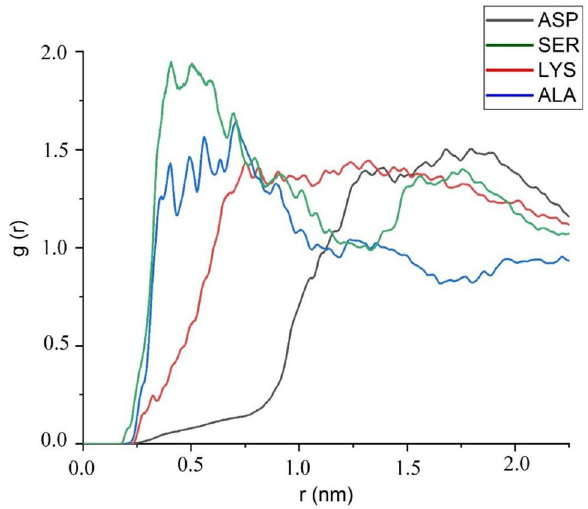
Figure 6. Radial distribution function of the amino acids around the BNNS surface in the study systems.